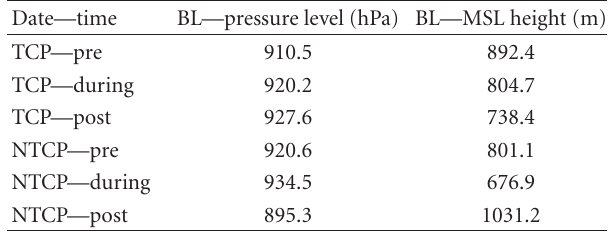
Table 4: Heights for the top of the tropical boundary layer as calculated from θ v . The heights are shown as pressure level (hPa) and MSL height (m). BL stands for boundary layer. The first three rows are for the mean TCP case for times prior to, during, and after MCS progression through the region. The last 3 rows are for the mean NTCP case for the same times as the mean TCP